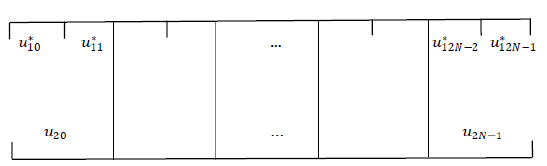
Figure 4. Schema of flowchart part II. a .